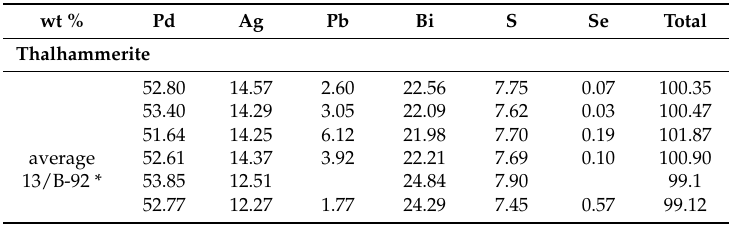
Table 2. Electron-microprobe analyses of natural and synthetic